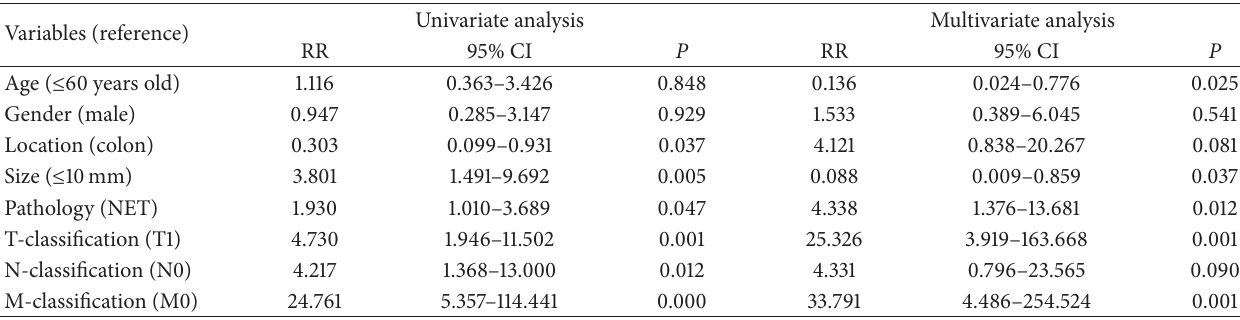
Table 2: Univariate and multivariate analysis (Cox proportional hazard model) of prognostic factors for 63 colorectal neuroendocrine neoplasm patients with complete